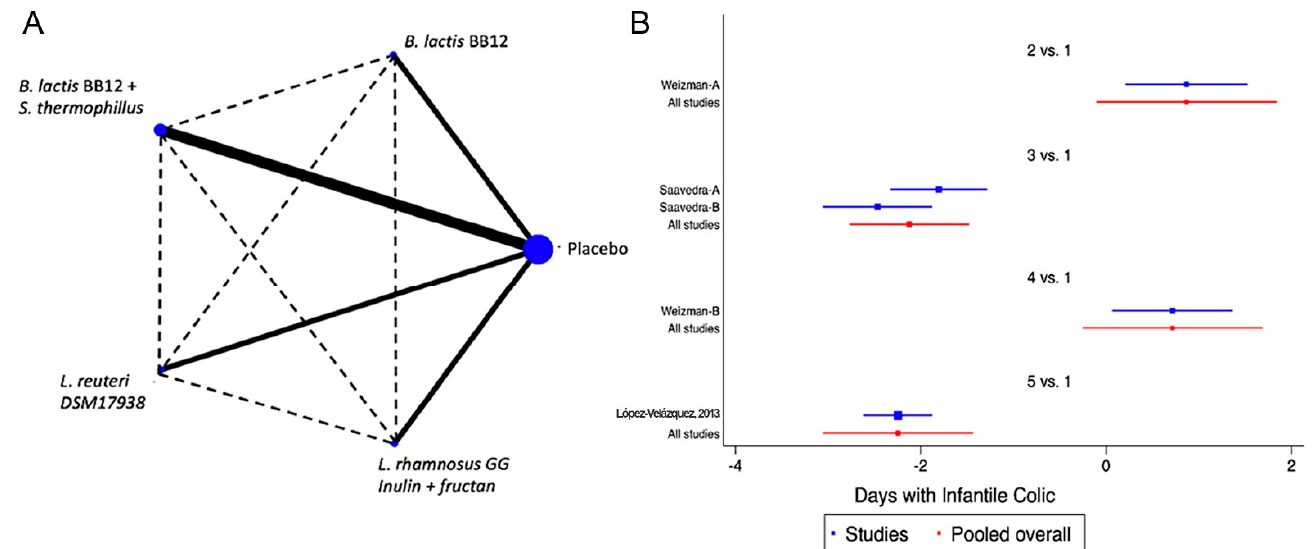
Figure 2. Network Meta-Analysis for probiotics in infant formula and colic. ( A ) Network diagram: the area of the blue nodes is based on the total number of patients for each respective interventions, the thickness of continuous lines represents the total number of studies comparing treatments/nodes vs placebo, dashed lines represent comparisons between two active interventions; ( B ) forest plot of multiple treatments.